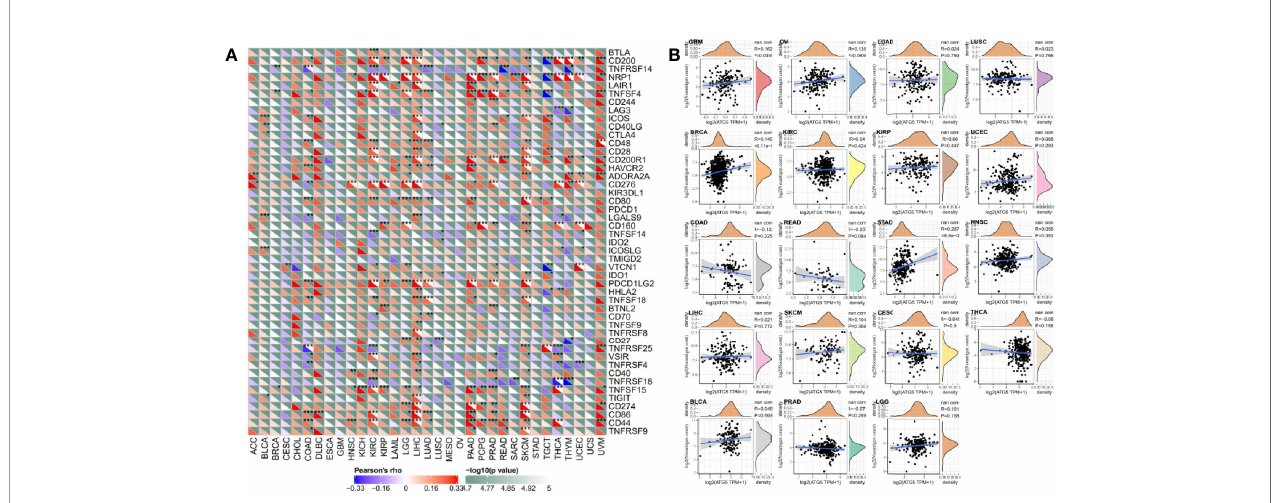
FIGURE 5 | Correlation analysis between ATG5 expression and immune neoantigens and immune checkpoint genes in pan-cancer. (A) Correlation analysis between ATG5 expression in Pan-cancer and immune checkpoint gene expression. *Signi fi cant correlation P < 0.05, **Signi fi cant correlation P < 0.01, ***Signi fi cant correlation P < 0.001. (B) Correlation analysis between ATG5 expression in pan-cancer and the number of tumor neoantigens in 19 types of tumors.